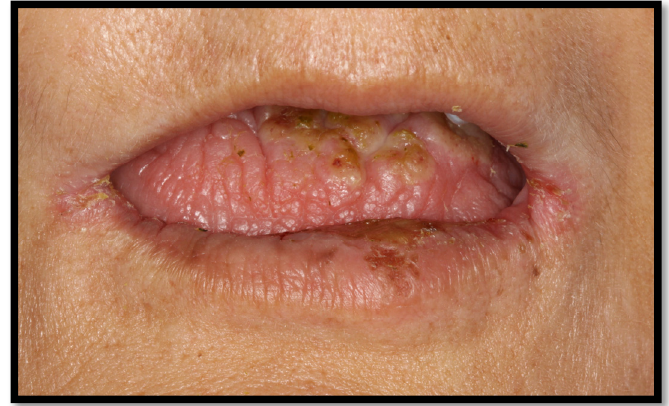
Figure 7. Tongue xerostomia and bilateral angular cheilitis.